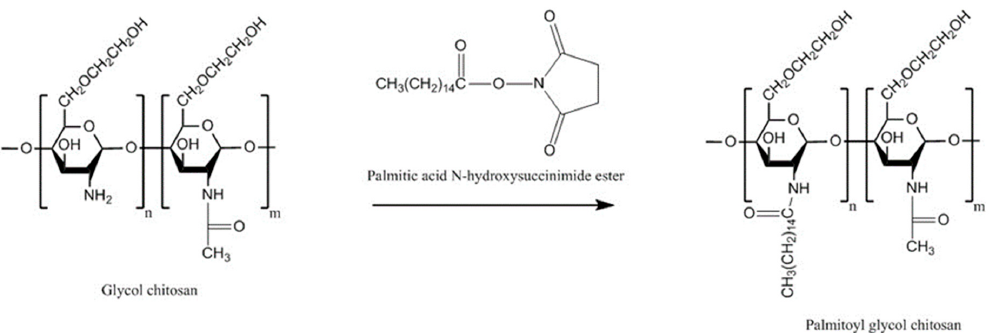
Figure 13. Synthetic pathway to palmitoyl glycol chitosan [130].